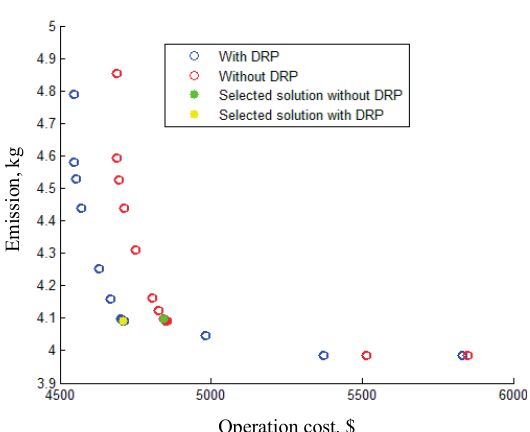
Fig. 4. Obtained results of each iteration.